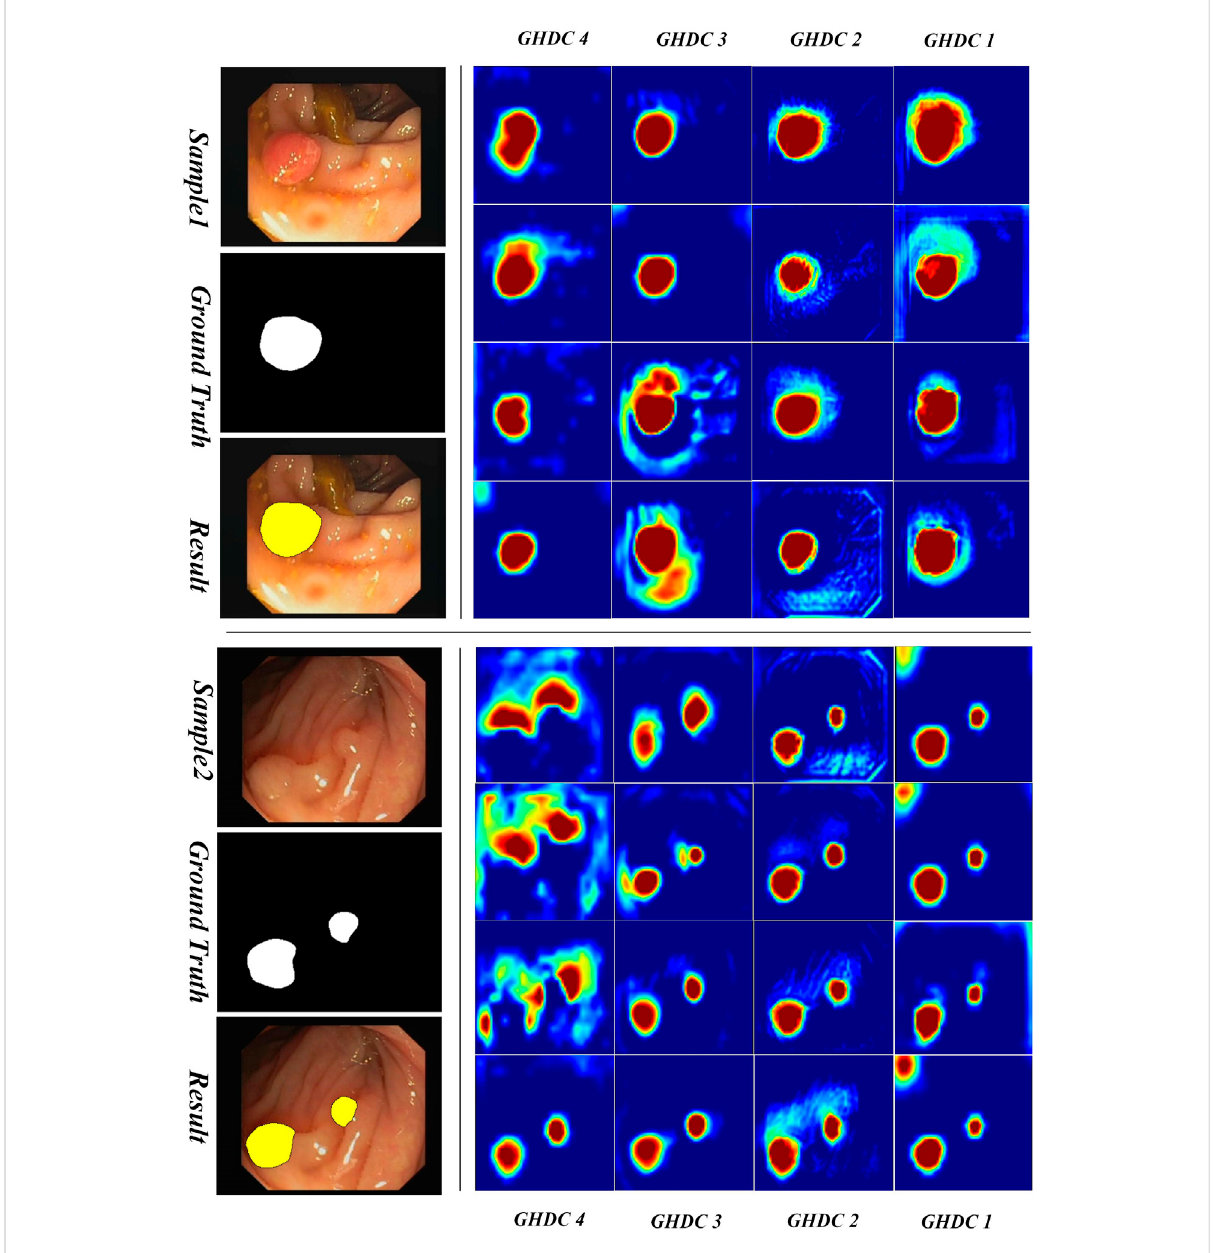
FIGURE 7 Visualization of the feature maps from the GHDC blocks on the CVC-ClinicDB dataset.